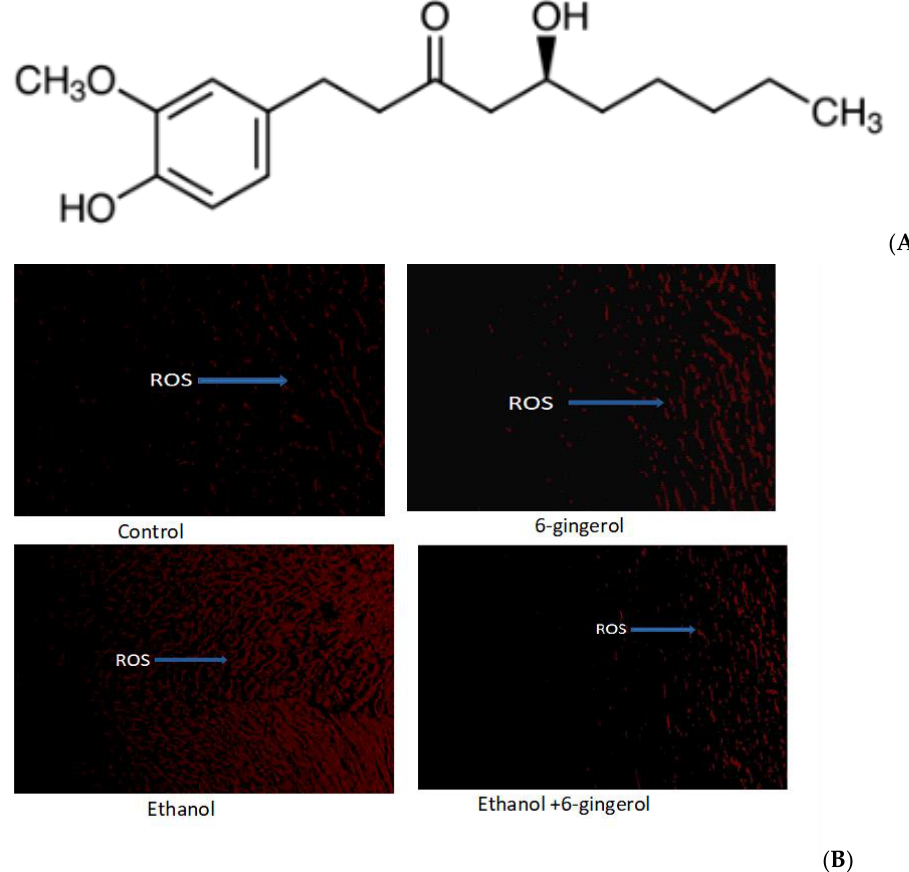
Figure 1. ( A ) Chemical structure of 6-gingerol. ( B ) Changes in intracellular ROS production in control, 6-gingerol, ethanol and 6-gingerol plus alcohol-fed rats.